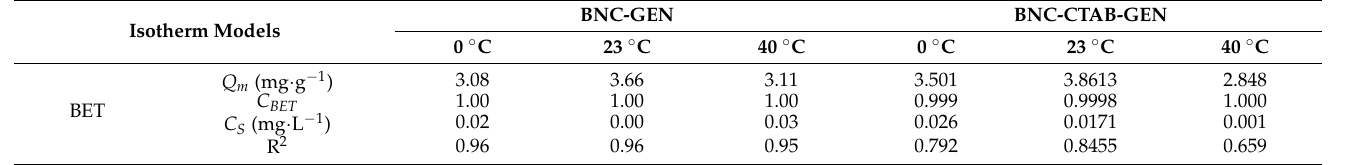
Table A1. Multilayer adsorption isotherm models for genistein adsorption in BNC and BNC-CTAB [38]. Isotherm